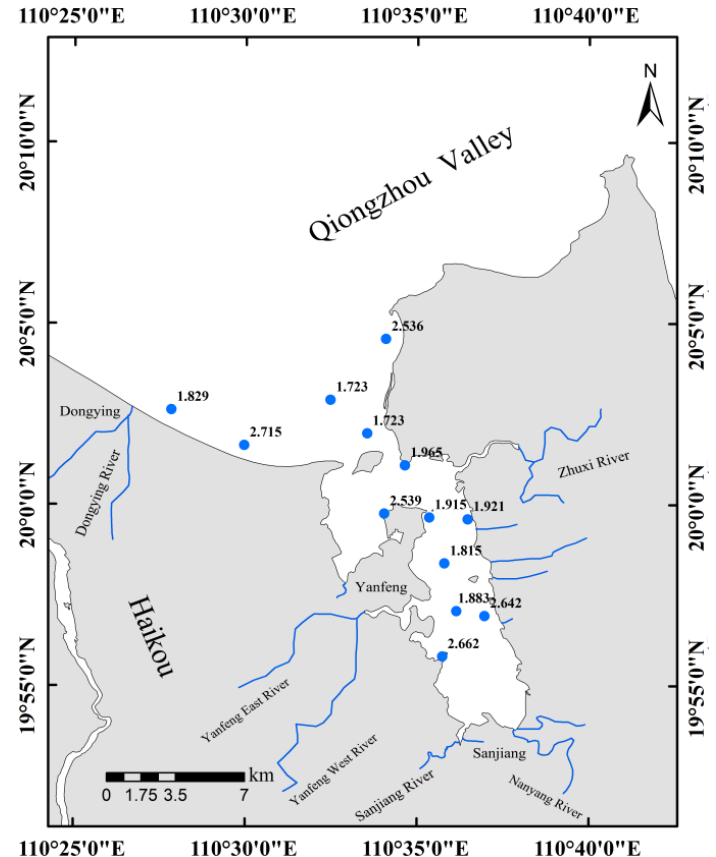
Figure 5. Consequences of comprehensive